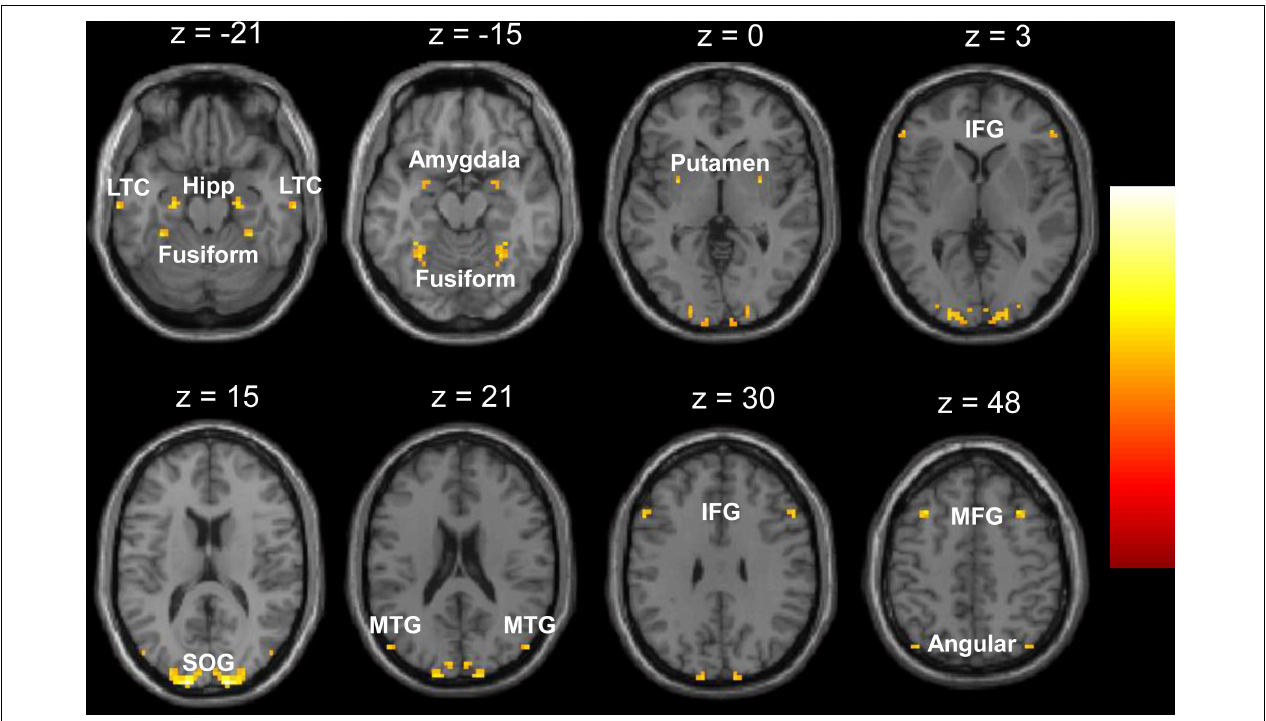
FIGURE 1 | Regions showing significant decrease of voxel-mirrored homotopic connectivity (VMHC) in the children with generalized tonic-clonic seizures (GTCS). The threshold of resulting statistical maps was a combination of p < 0.01 (FDR correction) and minimum cluster number of 6. Hipp, hippocampus; LTC, lateral temporal cortex; MTG, middle temporal gyrus; SOG, superior occipital gyrus; IFG, inferior frontal gyrus; MFG, middle frontal gyrus.